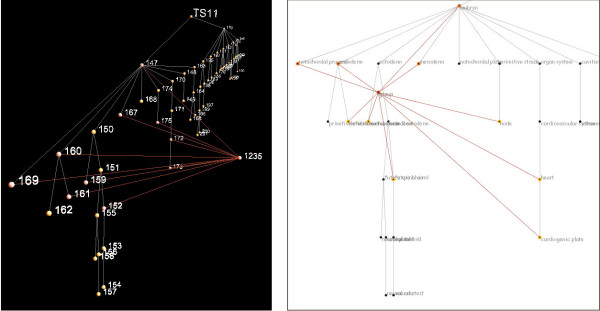
Comparison of visualisation of grouping in 3D to 2D. Removing the group node to a plane parallel to that in which the DAG lies (in 3D) not only makes it easier to identify the group created, but also prevents the crossing of links that occurs for grouping in the 2D browser.